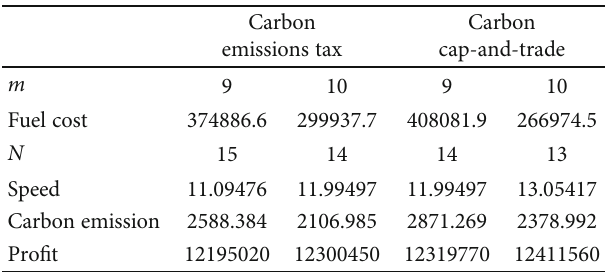
Figure 5: Marginal abatement costs. Table 9: Di ff erent ship type optimization results.